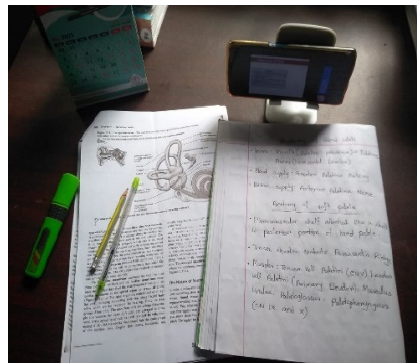
Figure 9. Alt-text: A woman with long hair smiling holding a smartphone.